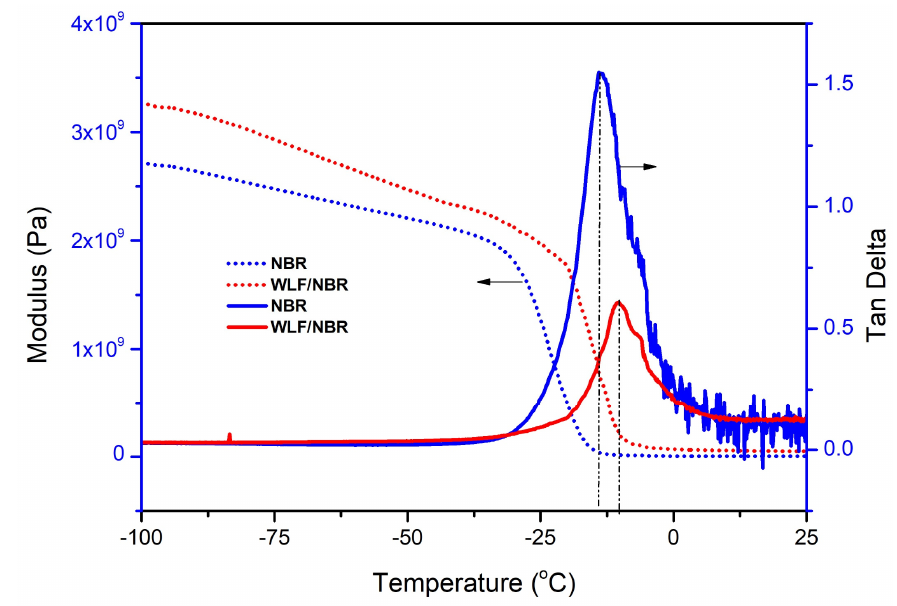
Figure 8. Dynamic mechanical properties of WLF/NBR composite.